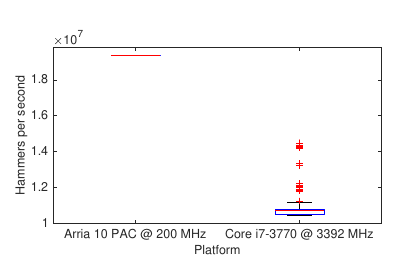
Figure 3: Distributions of flip rates on FPGA PAC and